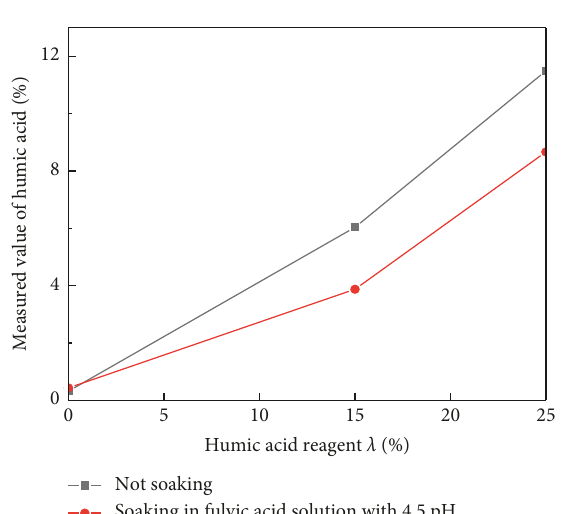
Figure 6: Relationship curve between measured FA content of samples and pH value of FA